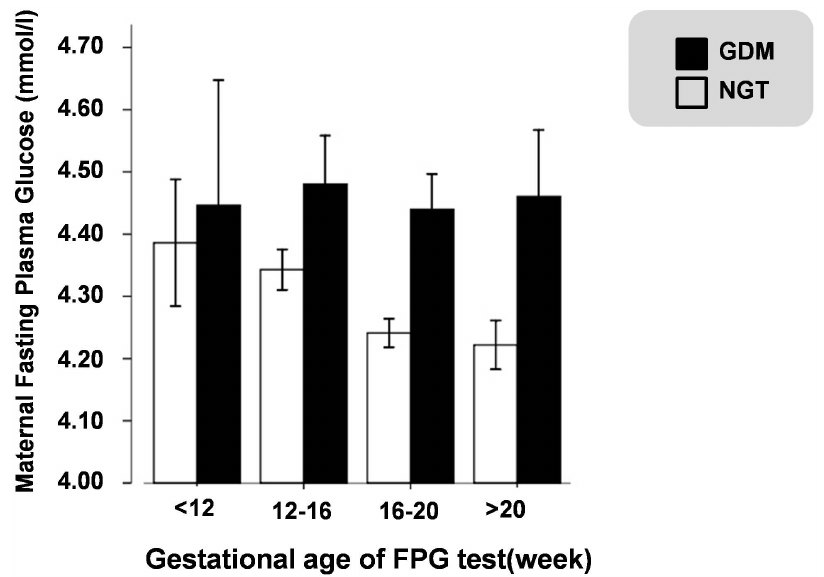
Fig. 2. Fasting plasma glucose concentrations for GDM and NGT groups in different gestational weeks.